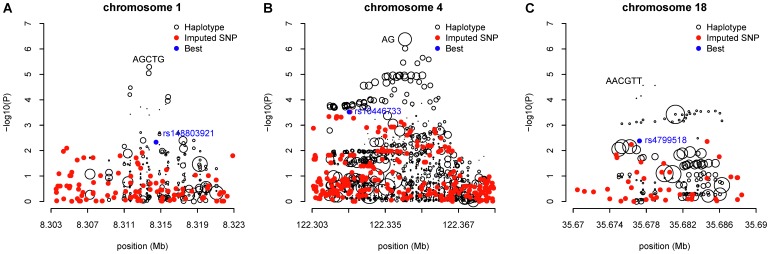
Comparison of the significance of individual haplotypes with imputed SNPs in regions on chromosomes 1, 4 and 18.Contrast of the haplotype effects with the effects of the 1000 Genome Project imputed SNPs in these three regions, namely, (A) chr1∶8,309,317-8,318,147; (B) chr4∶122,325,743- 122,363,114; and (C) chr18∶35,670,316-35,683,522 are shown. Black circles denote individual haplotypes, the sizes of which are proportional to their haplotype frequencies. Red dots denote imputed SNPs within the same region. Blue dot shows the most significant imputed SNP.